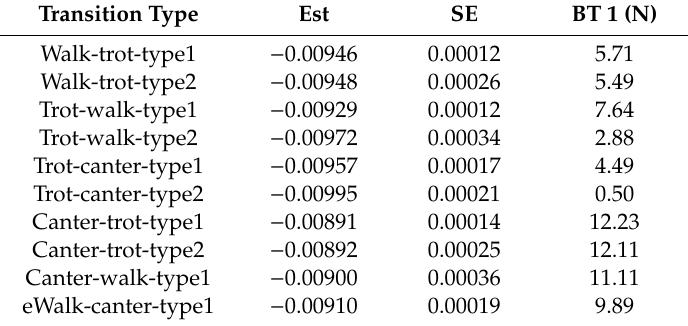
Table 4. Least square means estimates (Est) with standard errors (SEs) for rein tension before the transition model (model d). The outcome (transformed using the reciprocal inverse) is the di ff erence per rein between the rein tension during 1 s before the transition and the median gait-and rein-specific rein tension during the session. Thus, the tension in a walk-trot type 1 transition was subtracted by the walk median rein tension (per rein) etc. n = 913 observations based on 491 transitions. Transition types represented with only 1 transition are omitted from the